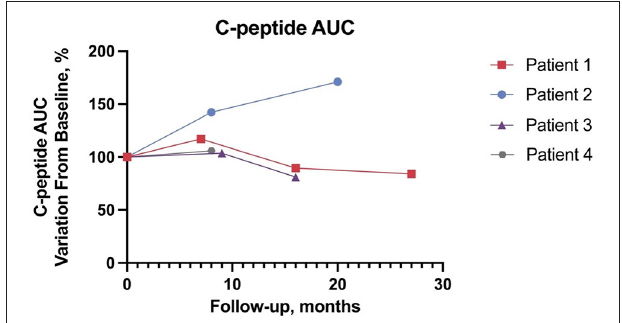
FIGURE 1 | C-peptide area under the curve, percentage variation from